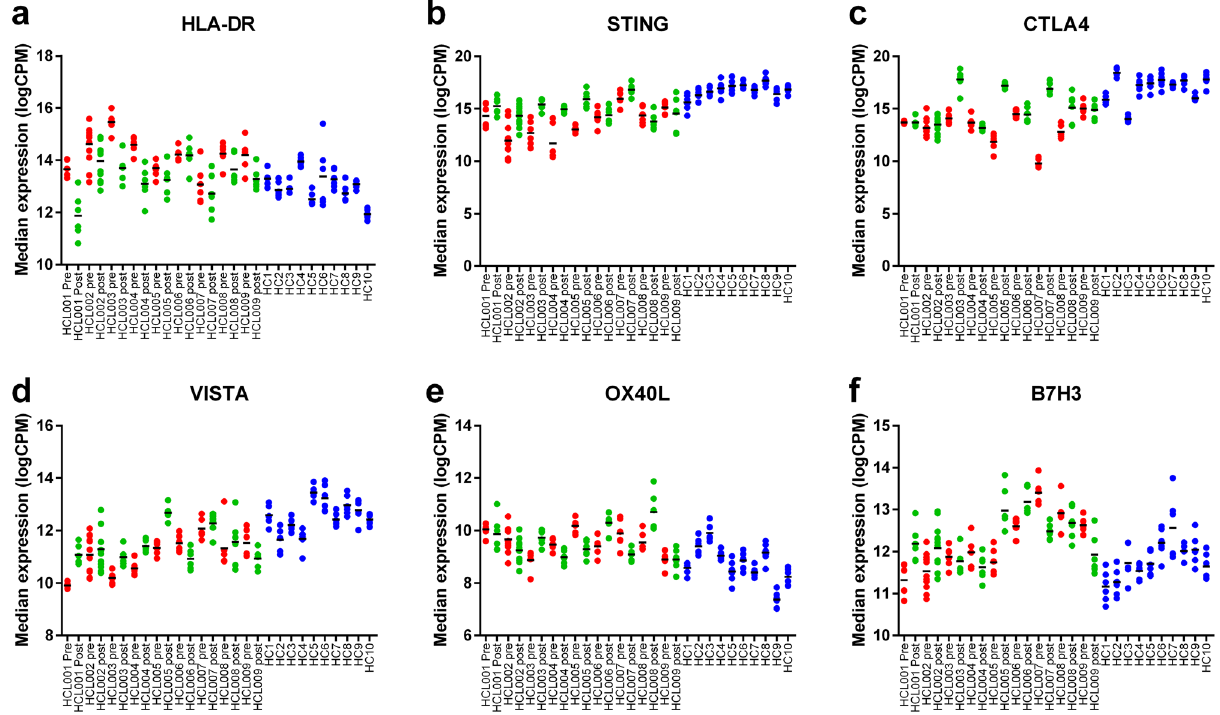
Figure 4. HCL patients’ exhibit altered expression in multiple immune markers that do not improve with CDA treatment. Expression of immune function markers pre- (red) and post-CDA (green) compared to control samples (blue). ( a ) HLA-DR, ( b ) STING, ( c ) CTLA4, ( d ) VISTA, ( e ) OX40L and ( f )